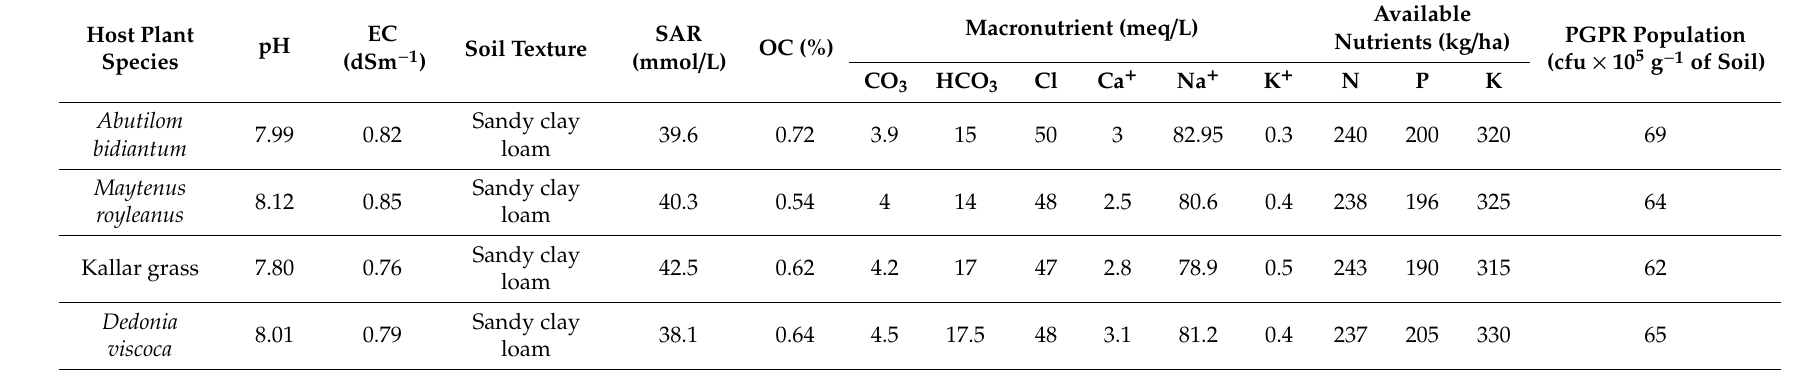
Table 1. Physiochemical properties of the rhizosphere soil and rhizobacterial